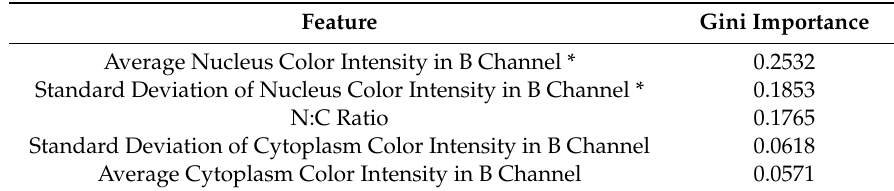
Table 8. The five most important features for classification of immature leukocytes based on Gini importance. Color intensity is calculated in the B channel of the component in LAB color space. Asterisk (*) indicates new features proposed in this